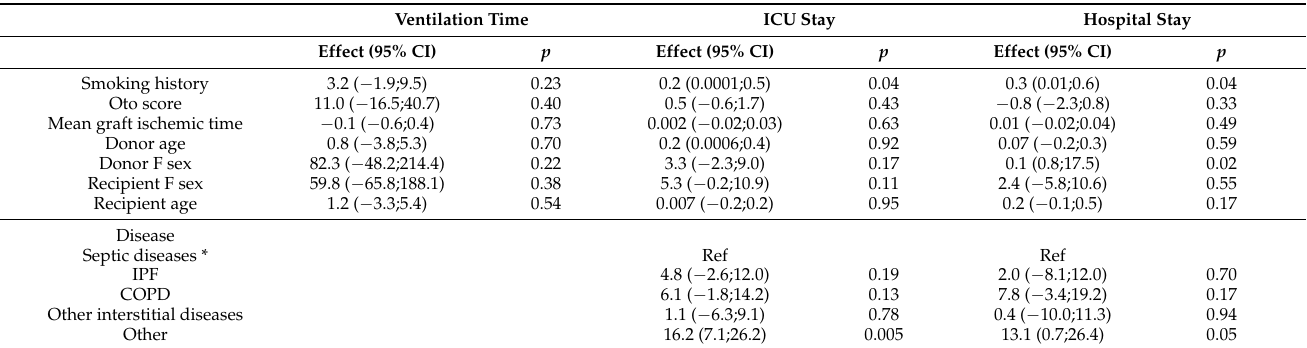
Table 6. Multivariate analysis of variables associated with postoperative ventilation, ICU, and hospital stay. Donor smoking history is considered as a continuous variable 1 .